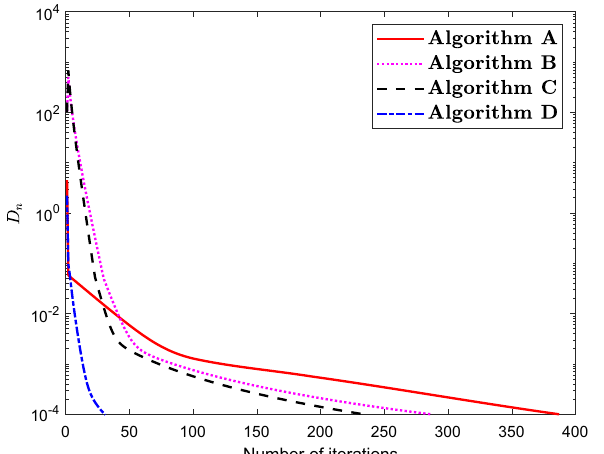
Fig. 3 Numerical illustration of Algorithm 1 with Algorithm 1 in [16] and Algorithm 3.1 in [1] and Algorithm 3.1 in [27] while m = 20